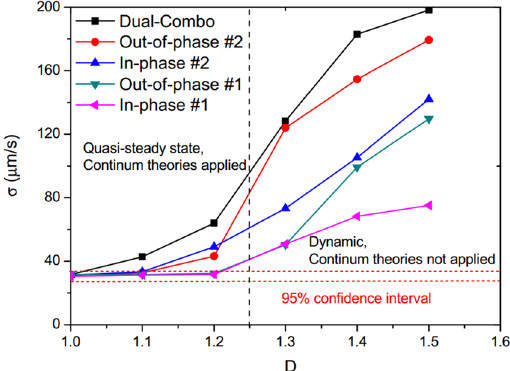
Figure 5. Correlation of the standard deviation ( σ ) of velocity variations and fracture D values in the five selected fracture